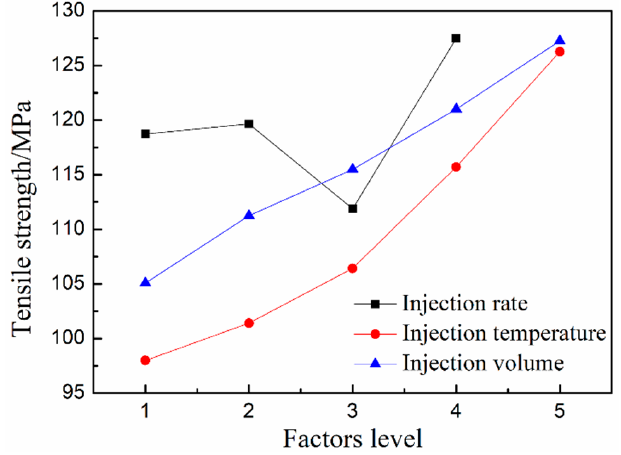
Figure 4. Tensile strength of GF/PA foams at different factor levels.